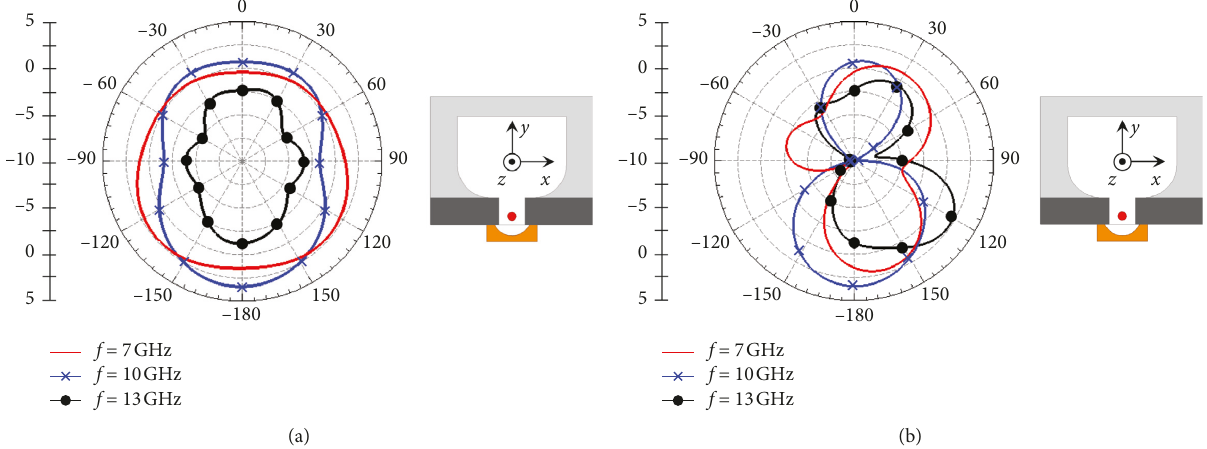
Figure 4: Radiation pattern for the ultra-wideband printed antenna. (a) xz -plane; (b) yz